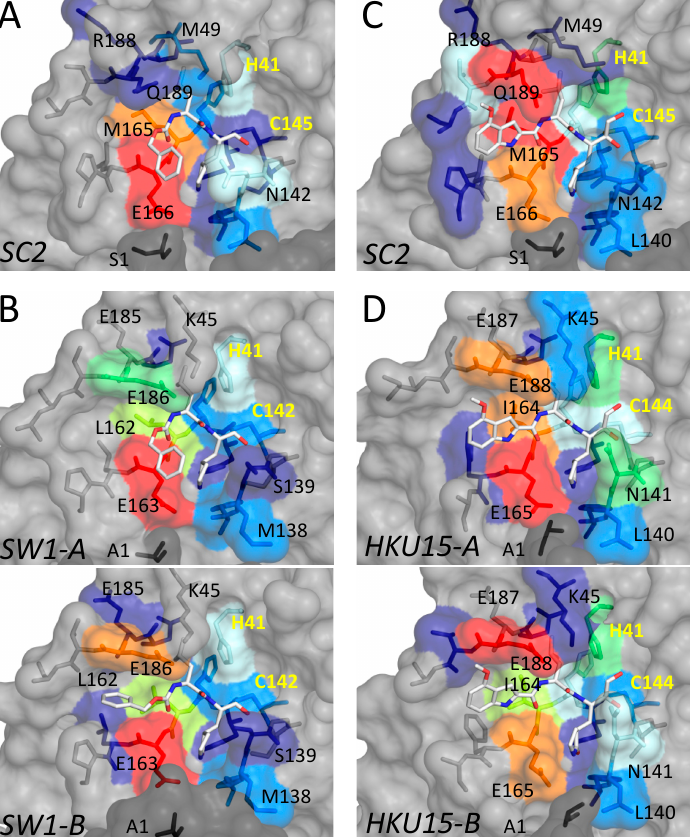
Figure 2. Packing of inhibitors with the active site residues in cocrystal structures of M pro in com- parison with SARS-CoV-2 (SC2). ( A , B ) Inhibitor GC376 bound to M pro from SARS-CoV-2 (PDB ID: 6WTJ) and gamma-CoV SW1 from the beluga whale. ( C , D ) Inhibitor PF-000835231 (active form PF-07304814) bound to M pro from SARS-CoV-2 (PDB ID: 8DSU; presented in this work) and porcine delta-CoV HKU15. Interactions at the active sites of the two protomers are indicated by A and B for SW1 and HKU15. In all panels, the active site residues are colored blue to red for increasing interactions with the bound inhibitor. The catalytic residues are labeled in yellow